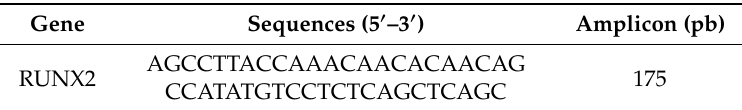
Table 1. Human primer sequences. Runt-related transcription factor 2 (Runx2), alkaline phosphatase (ALPL), osteocalcin (OC), and transferrin receptor (TFRC).